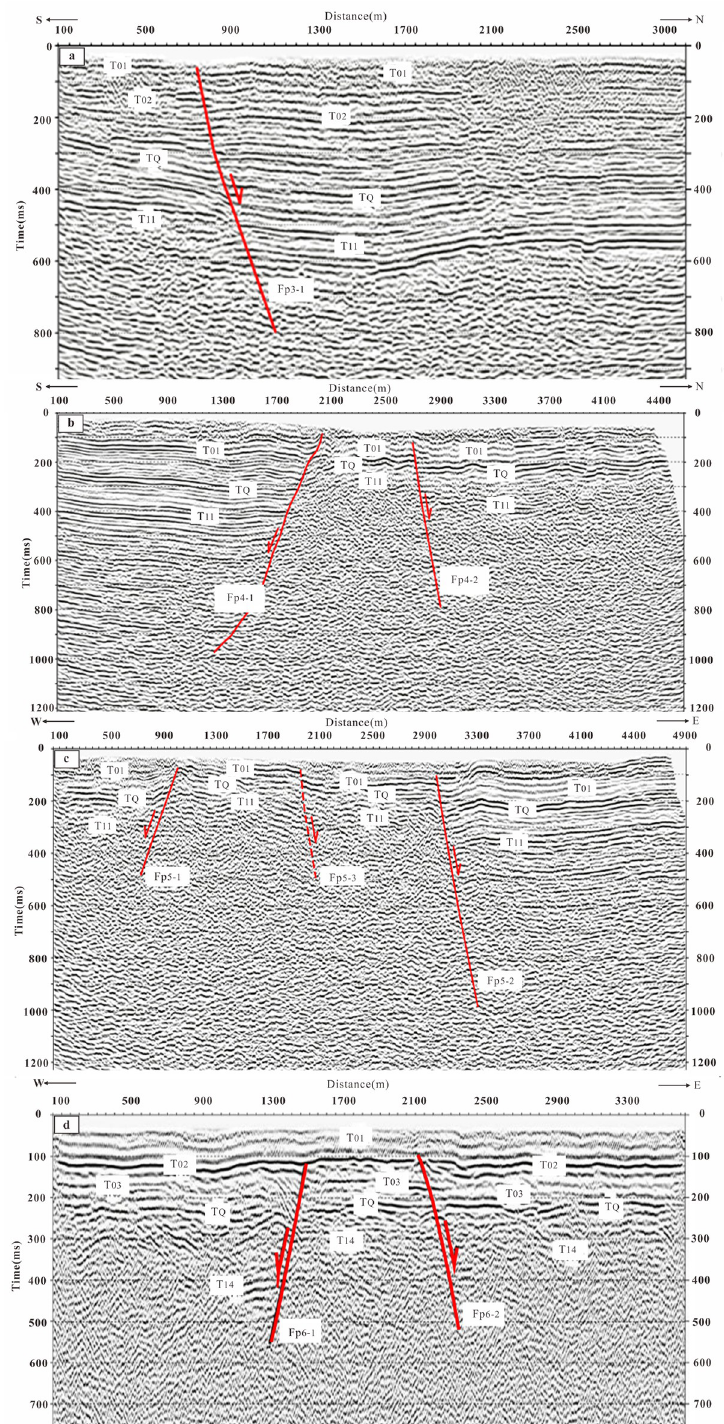
Fig 5. Seismic reflection time profile and geological interpretation of L3, L4, L5 and L6 exploration lines. (a) The time profile of seismic reflection migration of the exploration L3. (b) The time profile of seismic reflection migration of the exploration L4. (c) The time profile of seismic reflection migration of the exploration L5. (d) The time profile of seismic reflection migration of the exploration L6.